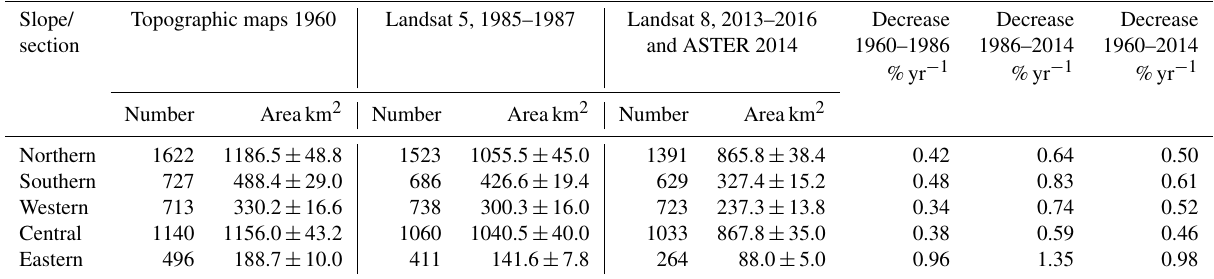
Table 2. The Greater Caucasus glacier number and area change according to the different slopes and sections in 1960–1986, 1986–2014 and 1960–2014.